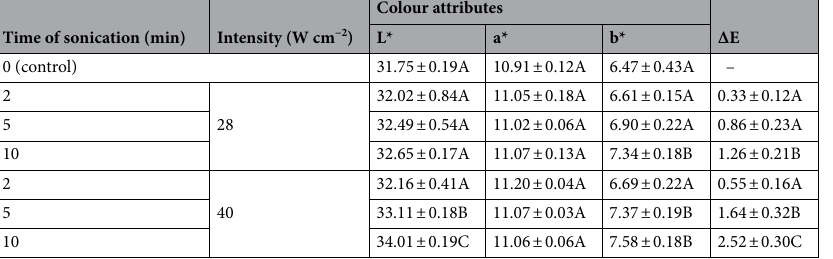
Table 2. Effects of ultrasound processing on colour attributes. Values with different letters in the same column are significantly different from each